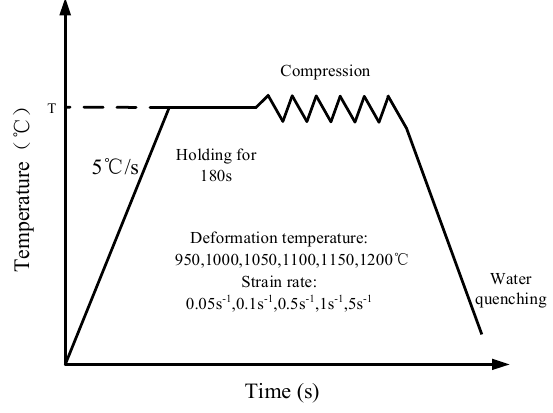
Figure 1. Compression processing.